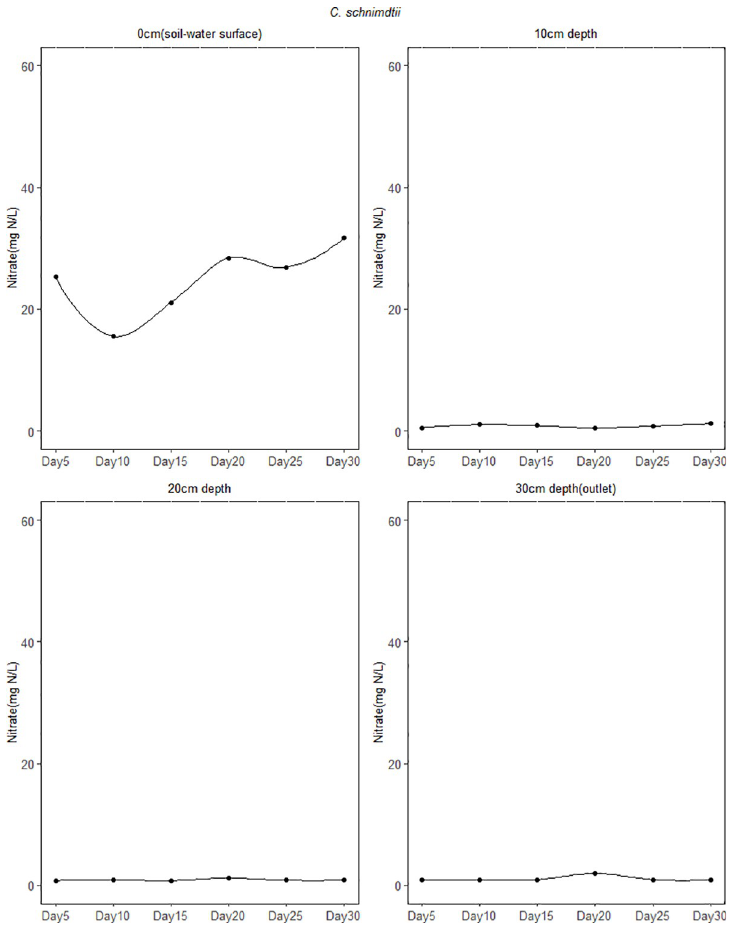
Fig 9. Temporal variation of NO (cid:0) concentration at different soil depth in the soil columns from site dominated 3 by C . schnimdtii .